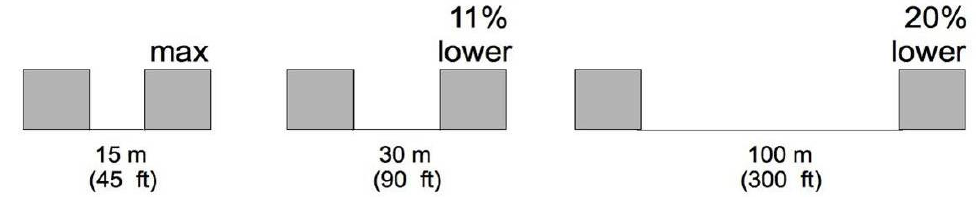
Figure 2. Relationship between street width (or setback) and building energy use (space heating).